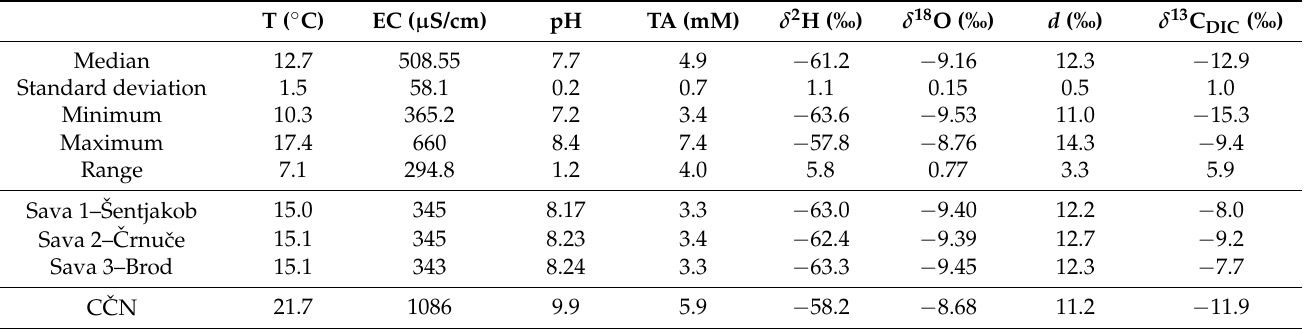
Table 2. Basic statistic parameters for temperature ( ◦ C), electrical conductivity ( µ S/cm), pH, total alkalinity (mM), and isotope composition of oxygen ( δ 18 O) and hydrogen ( δ 2 H), d-excess and isotopic composition of carbon in dissolved inorganic carbon ( δ 13 C DIC ) for all components in the system and the actual values for C ˇCN and locations at the River